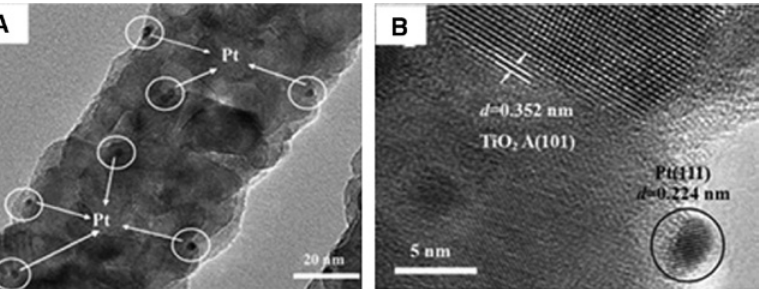
Figure 8: (A) TEM and (B) HRTEM images of the Pt/TF sample. For details, see Ref. [42]; reprinted with permission from Wiley.